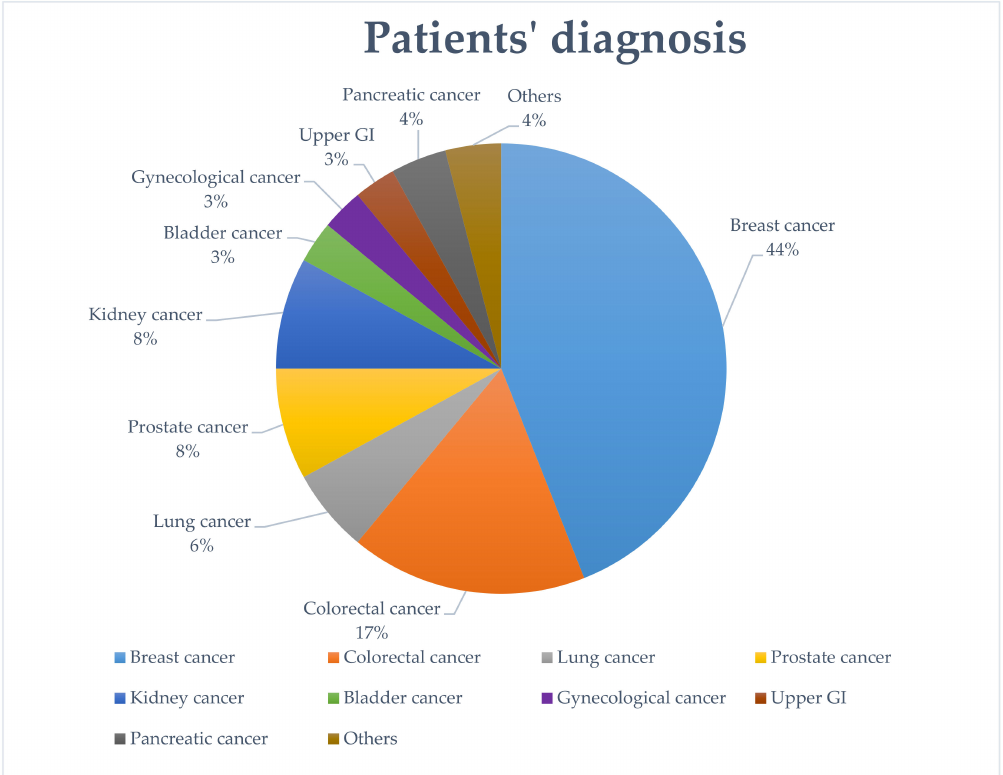
Figure 4. Image showing the diagnosis of patients accessing the hospital for cancer treatments in